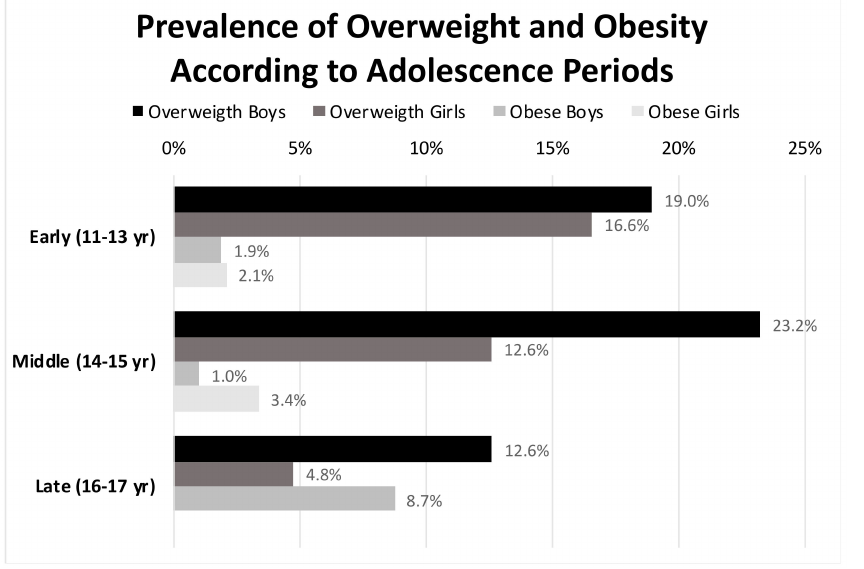
Figure 1. Changes in the prevalence of overweight and obesity in girls and boys along the three periods of the